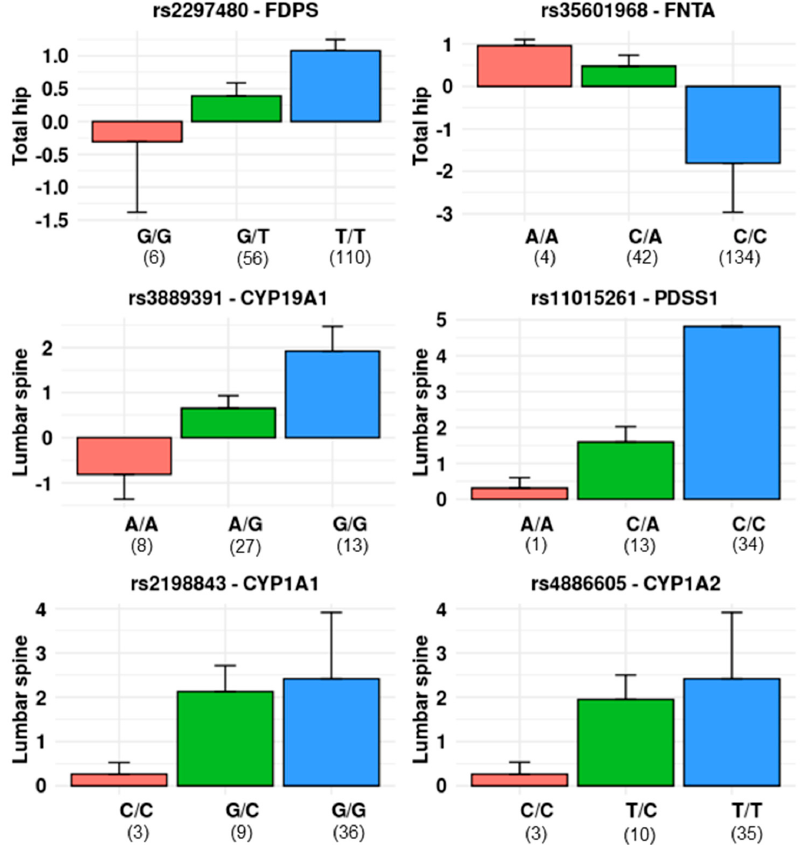
Figure 5. Barplots showing the percent of annual change in BMD (mean and SEM) across different SNP genotypes following bisphosphonate ( upper row panels) or SERM ( middle and lower row panels). Numbers in parentheses represent the number of women in each group.